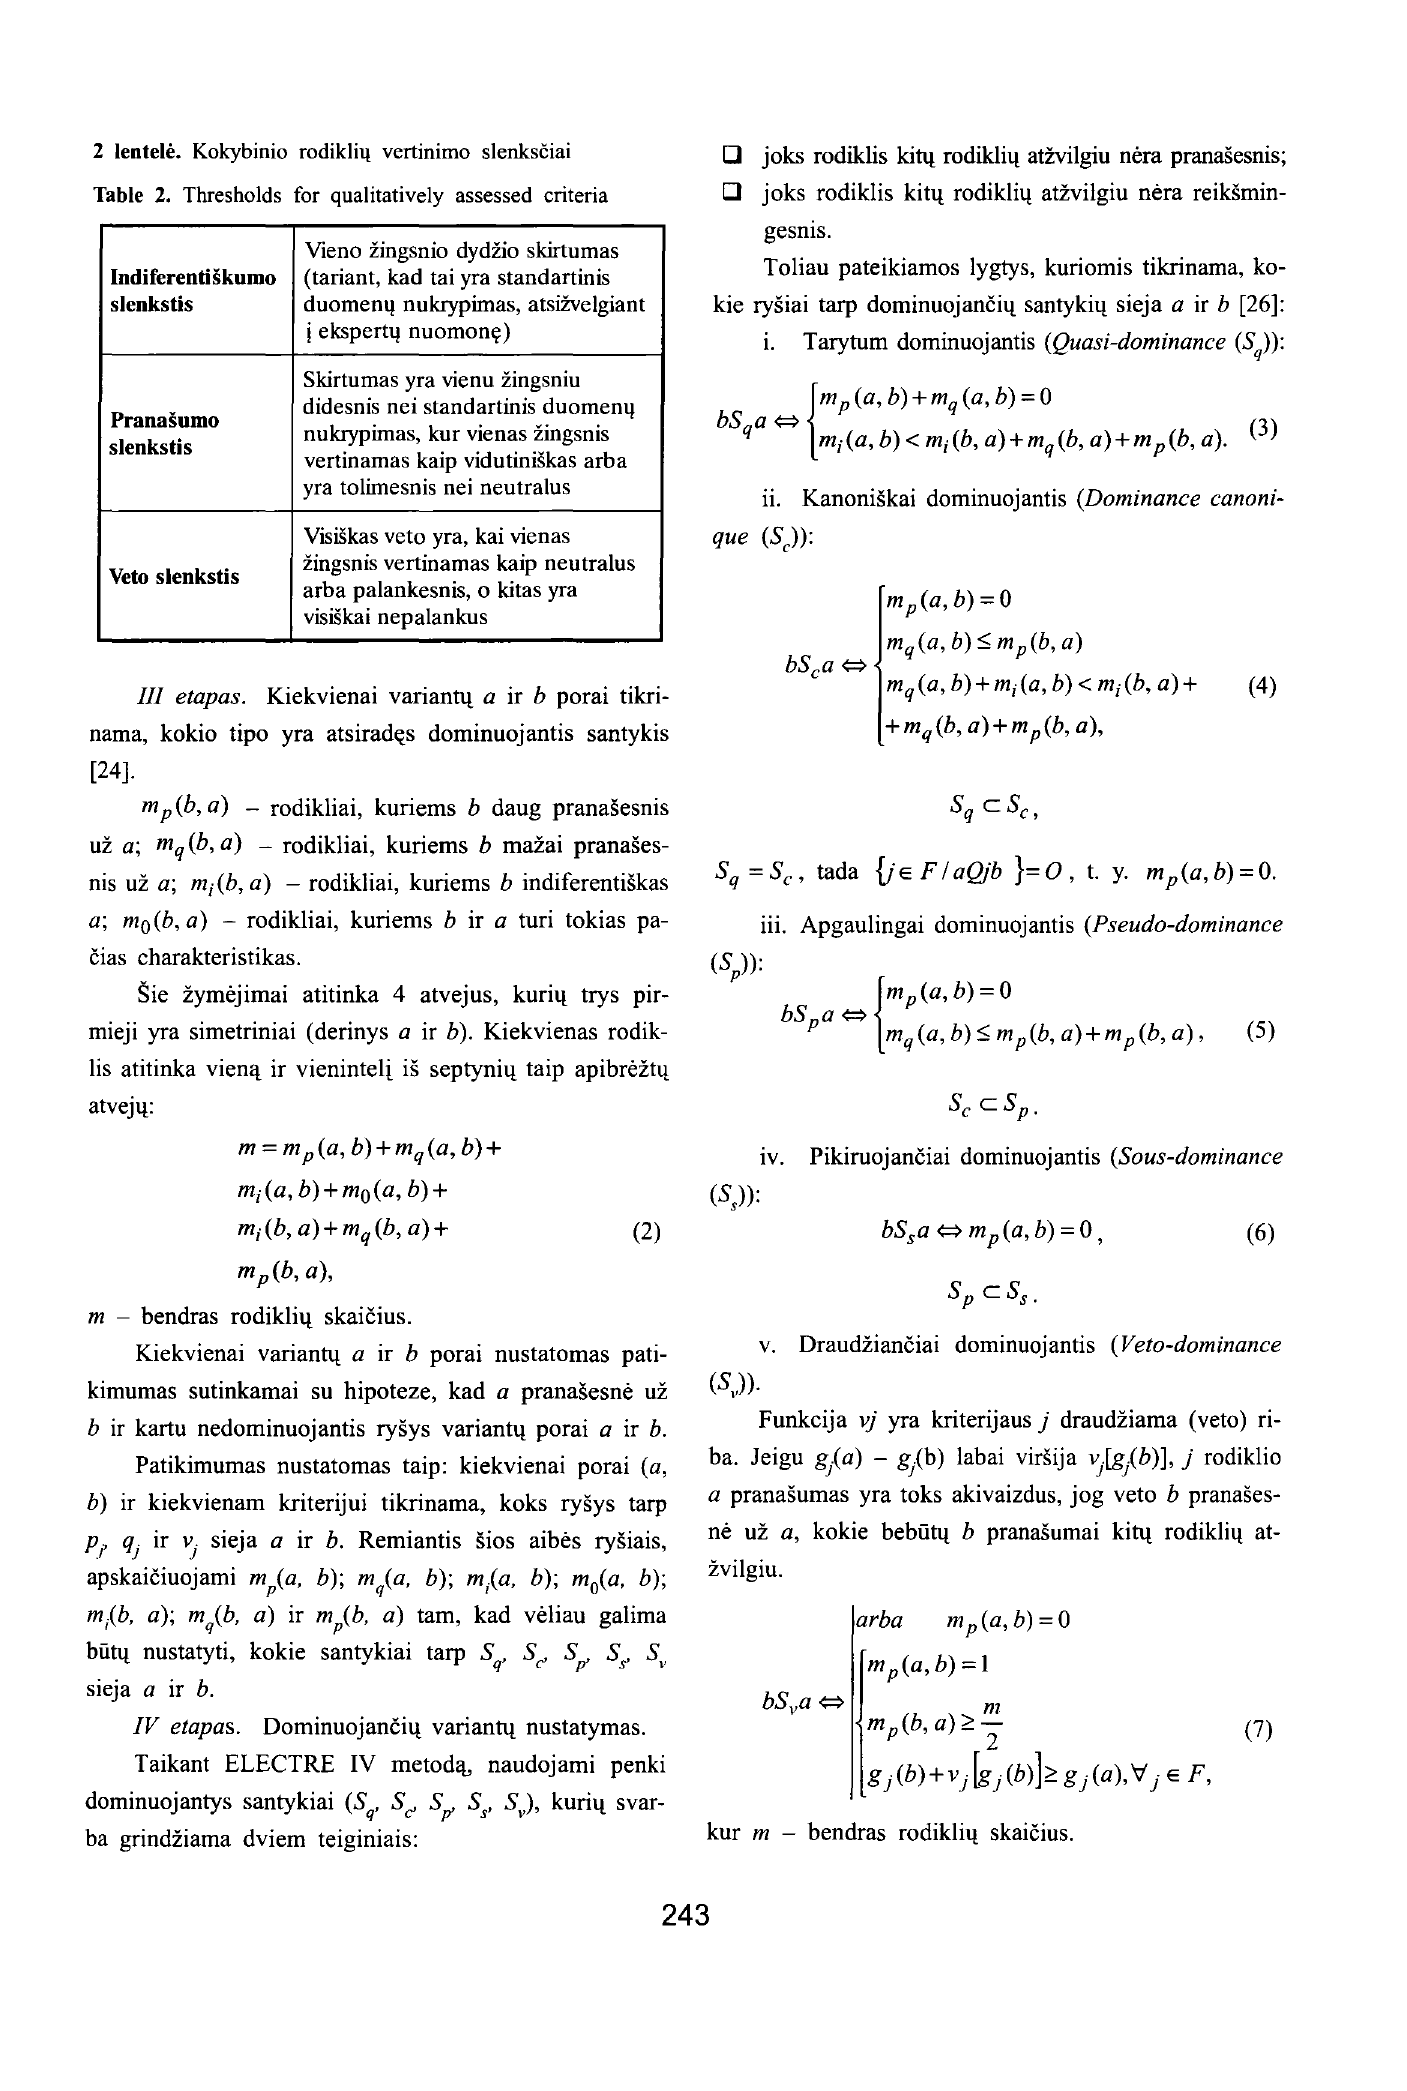
Table 2. Thresholds for qualitatively assessed criteria Vieno zingsnio dydzio skirtumas